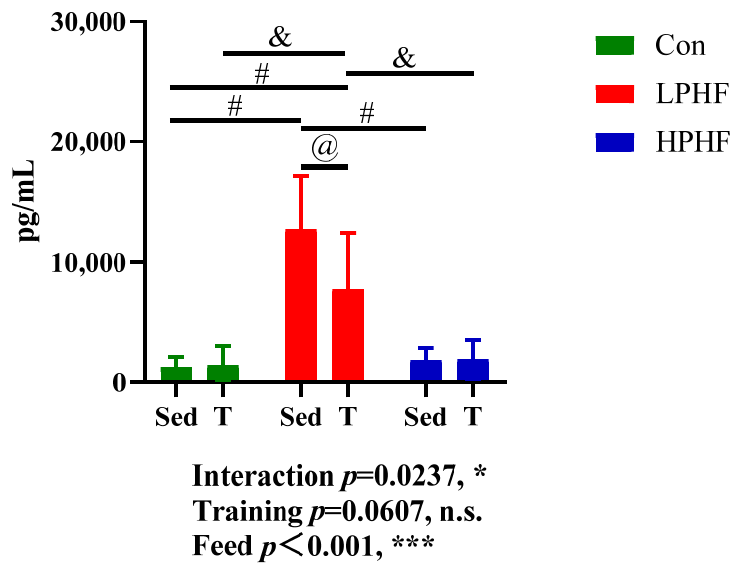
Figure 4. Plasma FGF21 concentration. FGF21, fibroblast growth factor 21. Con, LPHF, and HPHF represent chow diet, low-protein high-fat diet, and high-protein high-fat diet, respectively. Sed, sedentary behavior; T, training. Feed, training, and interaction indicate a dominant effect of diet, treadmill exercise, and the interactive effect between feed and training, respectively. n.s., no significance was observed. * p < 0.05 and *** p < 0.001. @, p < 0.05; &, p < 0.01; #, p < 0.001. Data are presented as the mean ± SD. n = 8 for each group. Significance in the differences between means was determined by Tukey’s post hoc test when ANOVA revealed a significant effect from interaction of diet and training.